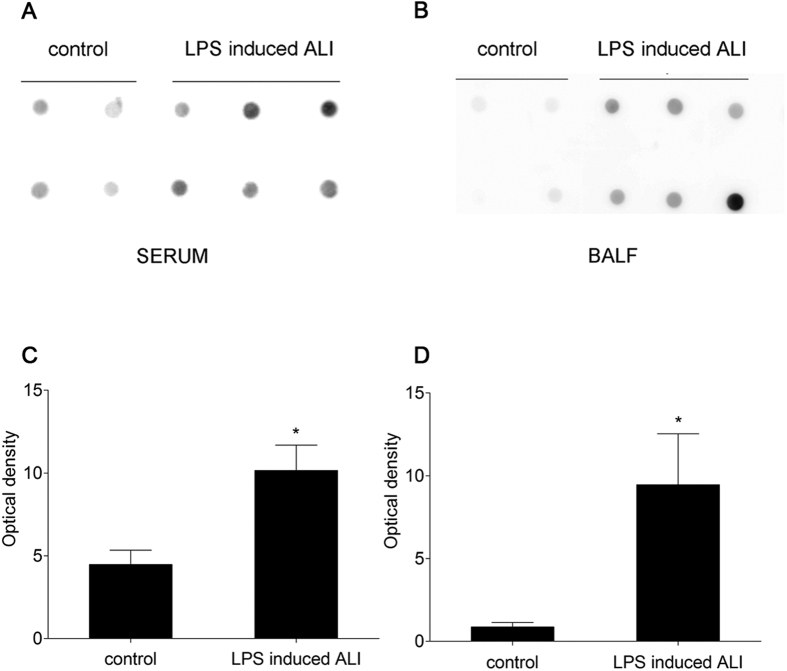
Representative dot blots for sCD74 in serum and bronchoalveolar lavage fluid from randomly selected mice.sCD74 was strongly positive in both serum and bronchoalveolar lavage fluid in the mice with acute lung injury. In contrast, sCD74 was negative in some of the control serum samples and was absent in control bronchoalveolar lavage fluid samples. (A: 10 serum samples; B: 10 bronchoalveolar lavage fluid samples) Relative protein levels were quantified by densitometry and expressed as optical density ratio (C,D). Data are presented as mean ± SEM, *p < 0.05 compared to control with Student t test.